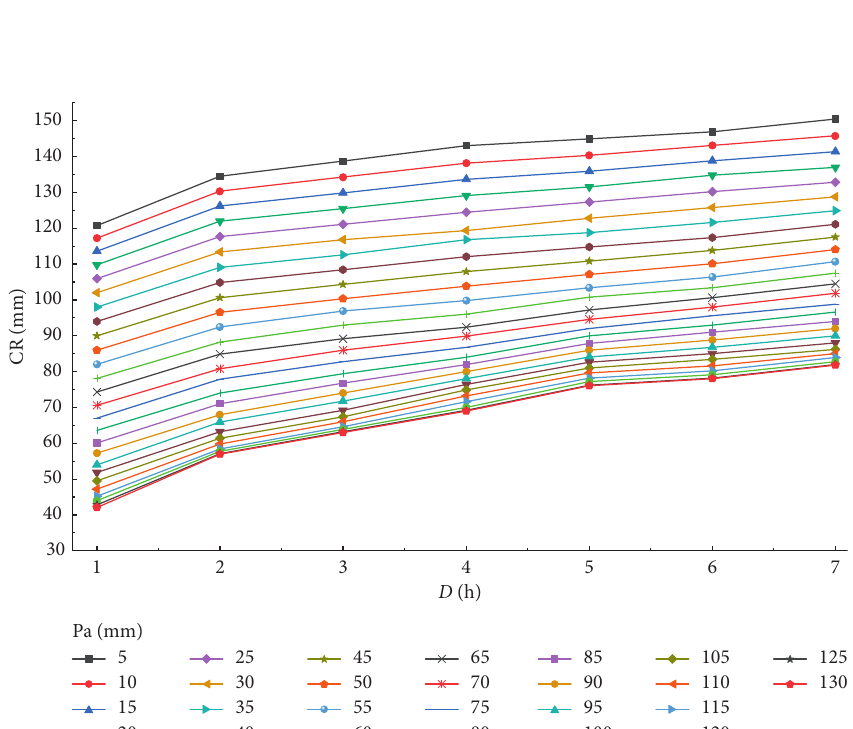
Figure 9: CR- D curves of different